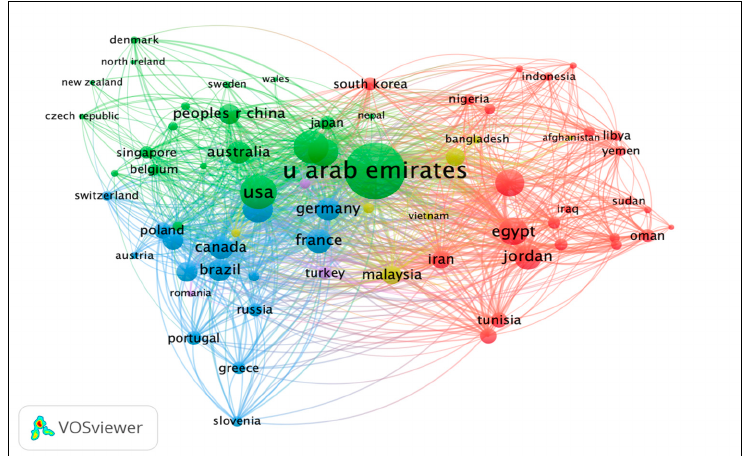
Figure 6. Co-authorship countries’ network visualization based on TLS. Different colors represent different clusters, while the nodes represent the contribution of a country while the links represent the linkage/collaboration between countries. The bigger the node, the higher contribution; the thicker the linkage/line, the stronger the collaboration.